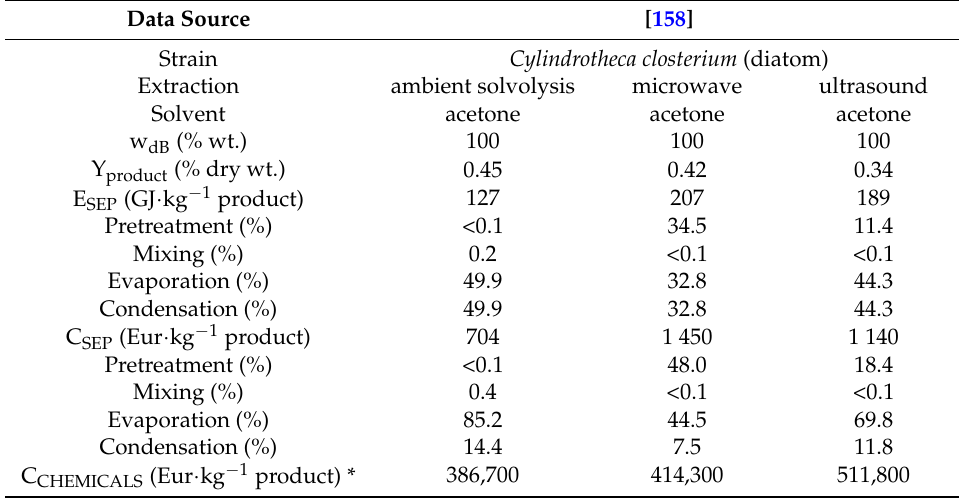
Table 4. Energy requirement, energy and production costs for fucoxanthin